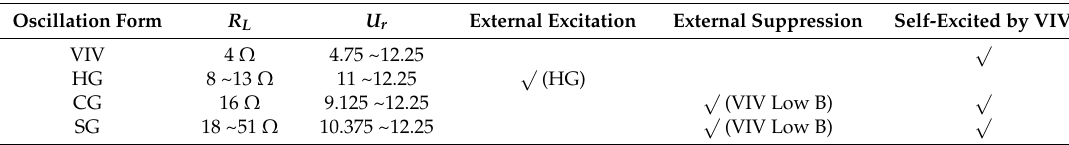
Table 3. VIV and galloping occurrence conditions with K = 1400 N/m.